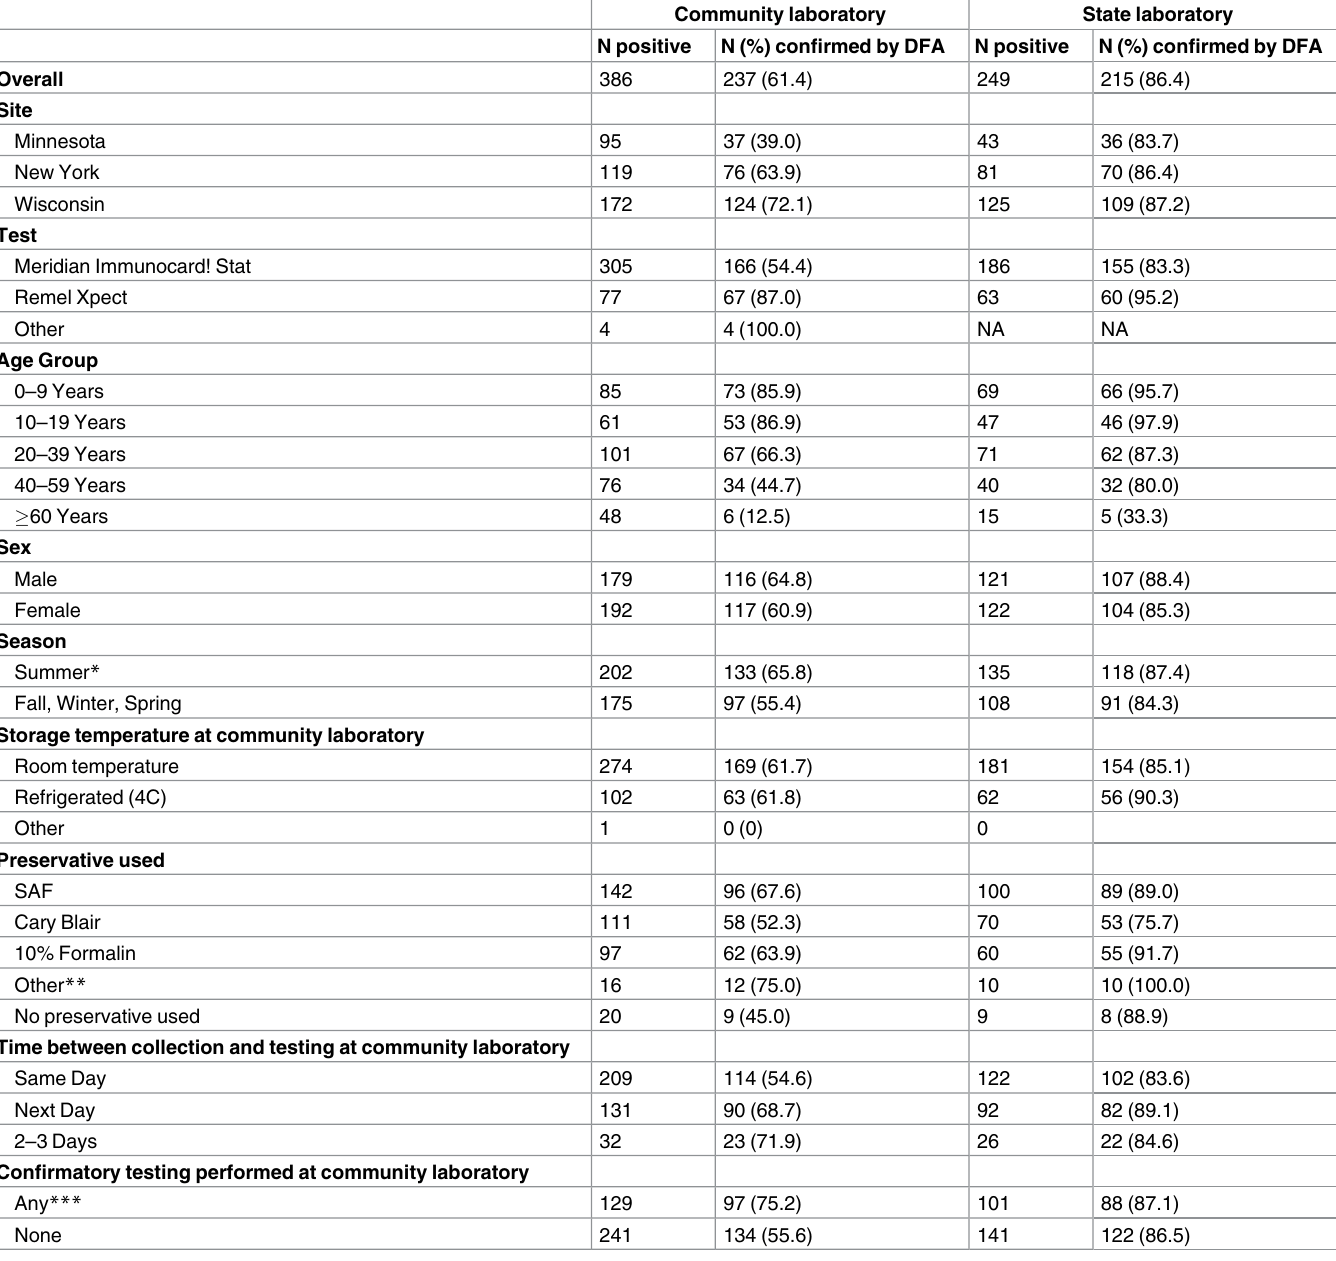
Table 2. Results of direct fluorescent antibody testing (DFA) for stool specimens that tested positive for Cryptosporidium infection by rapid car- tridge assay at community laboratories (n = 386) or repeat rapid cartridge assay at state public health laboratories (n =